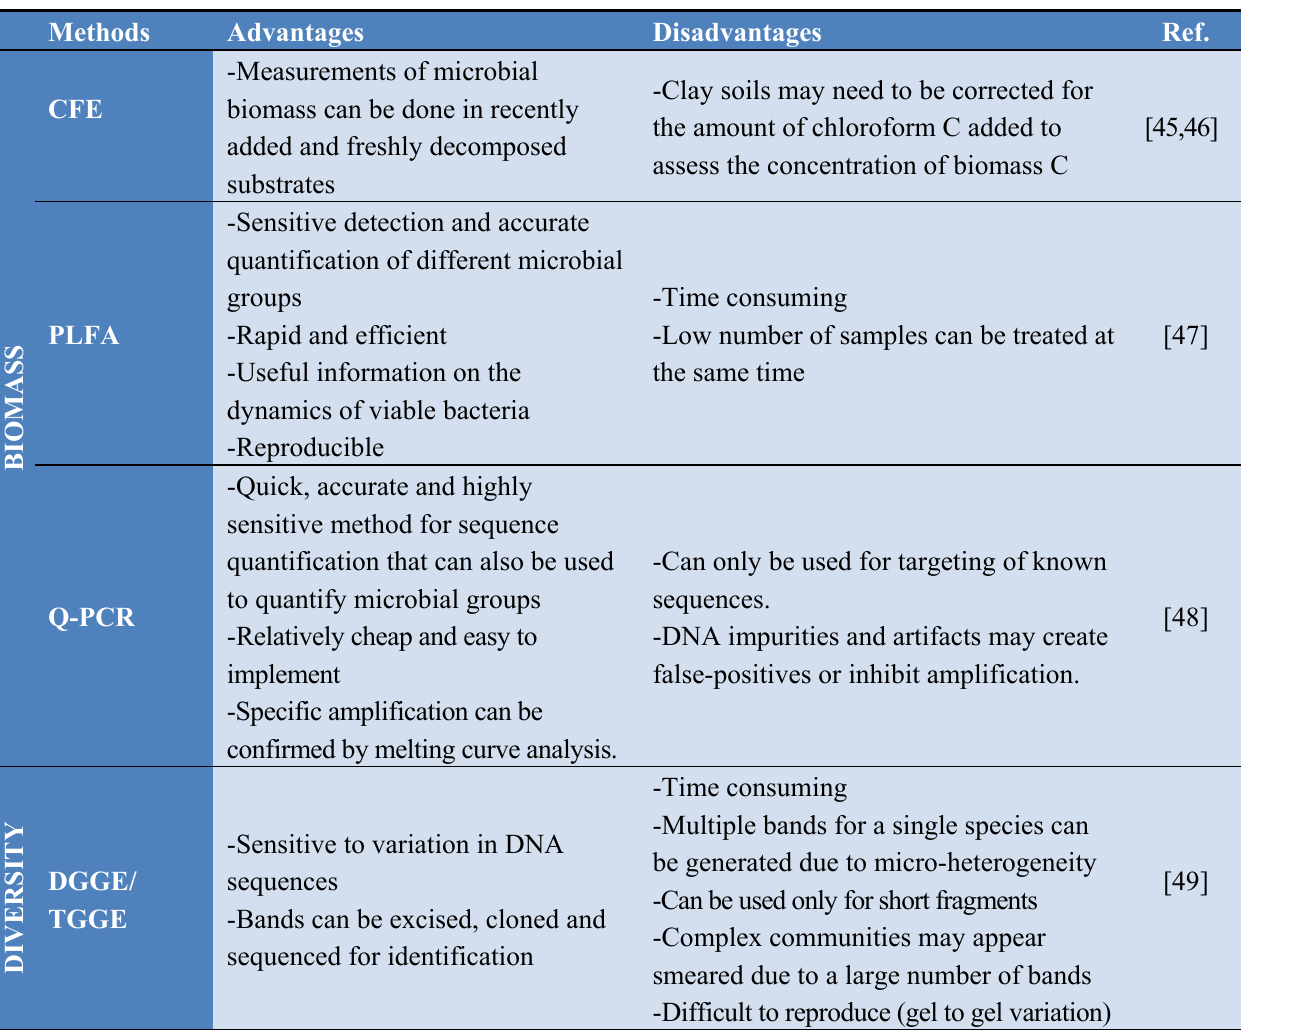
Table 1. Advantages and disadvantages of molecular methods described in this study to characterize soil microbial communities. Methods are sorted based on their ability to profile microbial biomass, diversity or activity. Chloroform Fumigation-Extraction (CFE); Phospholipid Fatty Acid Analysis (PLFA); Quantitative PCR (Q-PCR); Denaturing Gradient Gel Electrophoresis (DGGE); Temperature Gradient Gel Electrophoresis (TGGE); Single-Strand Conformation Polymorphism (SSCP); Terminal Restriction Fragment Length Polymorphism Fingerprinting (T-RFLP); Automated Ribosomal Intergenic Spacer Analysis (ARISA/RISA); Length-Heterogeneity PCR (LH-PCR); Random Amplified Polymorphic DNA (RAPD); Amplified Ribosomal DNA Restriction Analysis (ARDRA); Fluorescence In Situ hybridization (FISH); Fluorescein Diacetate (FDA); Stable-Isotope Probing